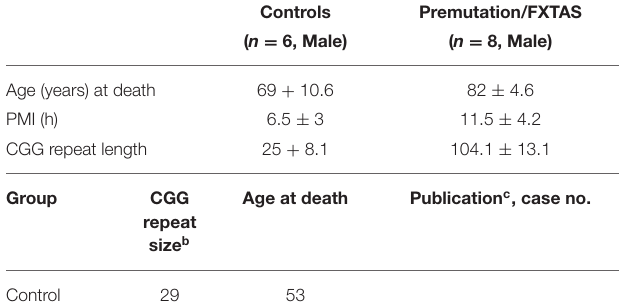
TABLE 1 | Subject demographics (males) a